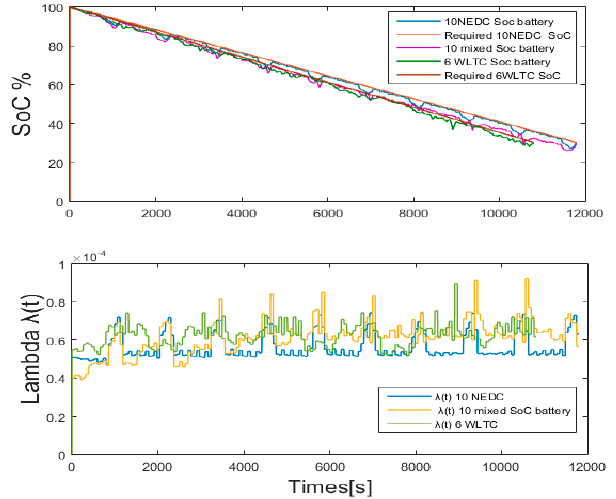
Figure 15. SoC and lambda variation of the proposed online L-Control algorithm for PHEV during 10 MIXED cycles, 6 WLTC, and 10 NEDC cycles.